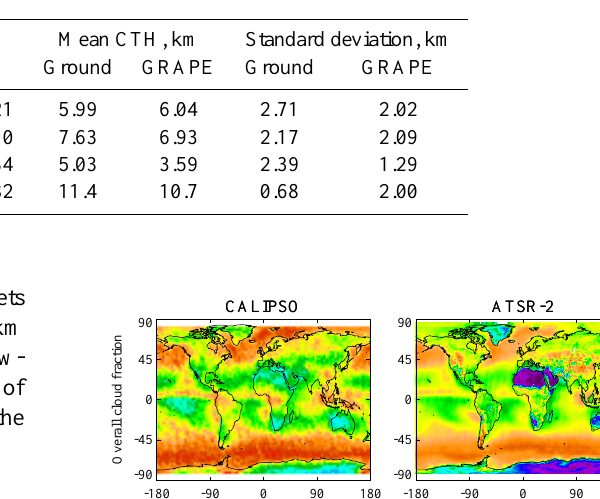
Table 5. As Table 4, except for deep clouds.